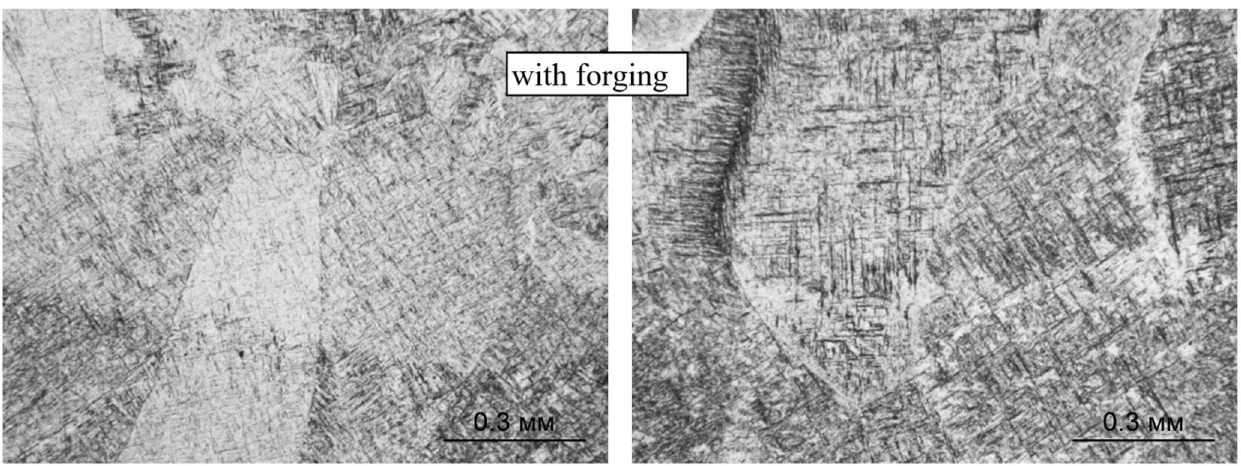
Figure 10. Boundaries between the deposited layers during CMT deposition with forging; ×100.